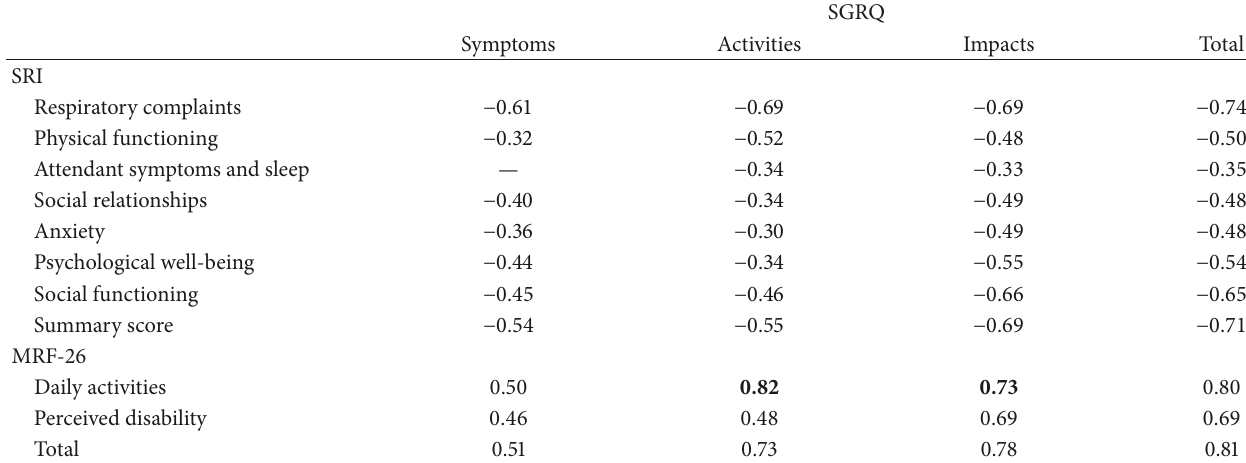
Table 2: Correlations between HRQL